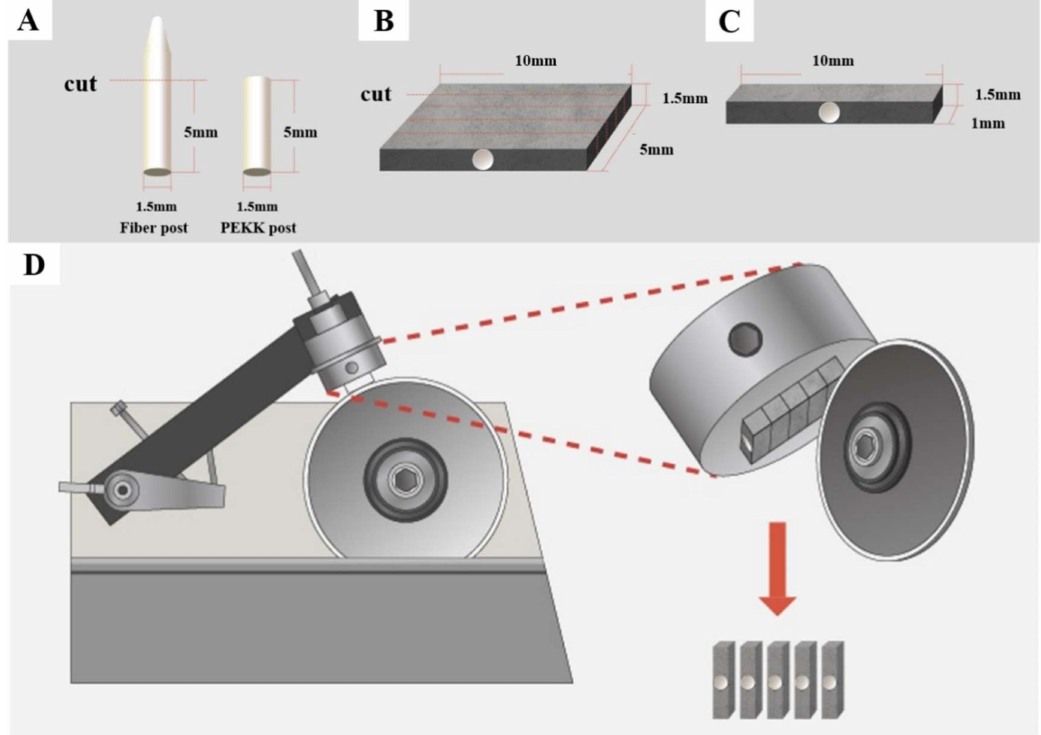
Figure 1. Creating bar type specimens for microtensile bond strength (MTBS) testing; ( A ) the fiberglass and PolyEtherKetoneKetones (PEKK) posts, 1.5 mm in diameter and 5 mm in length, were